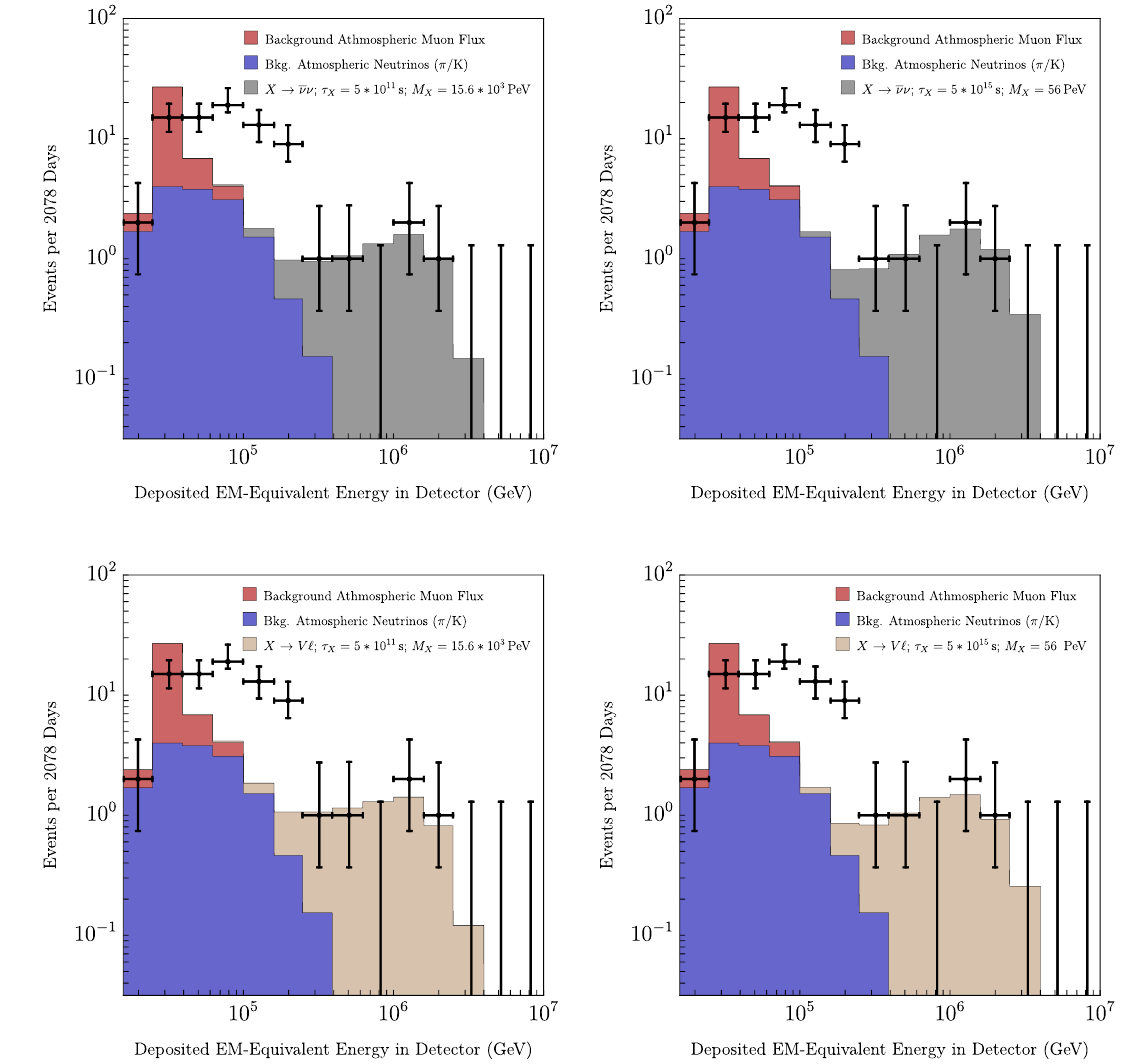
Figure 4 . Neutrino spectrum forecast for decay model I and II for two di(cid:11)erent allowed lifetimes. The displayed spectrum shows the best mass (cid:12)t for the 0 : 250{4 PeV neutrinos to DS1 for a short sample lifetime (cid:28) X = 5 (cid:3) 10 11 s on the left, and a long sample lifetime (cid:28) X s